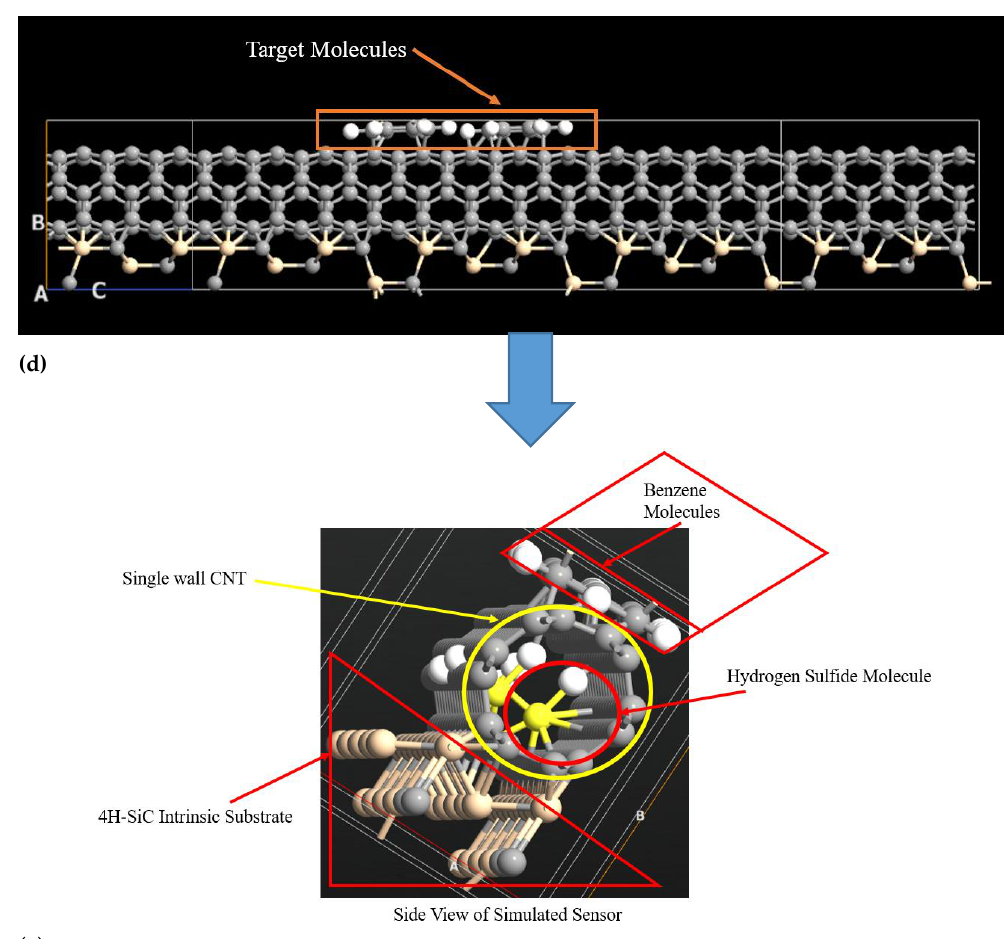
Figure 1. Simulation of single-wall carbon nanotube-based hydrogen-sulfide and benzene detector in Quantumwise Atomistix Toolkit Software.